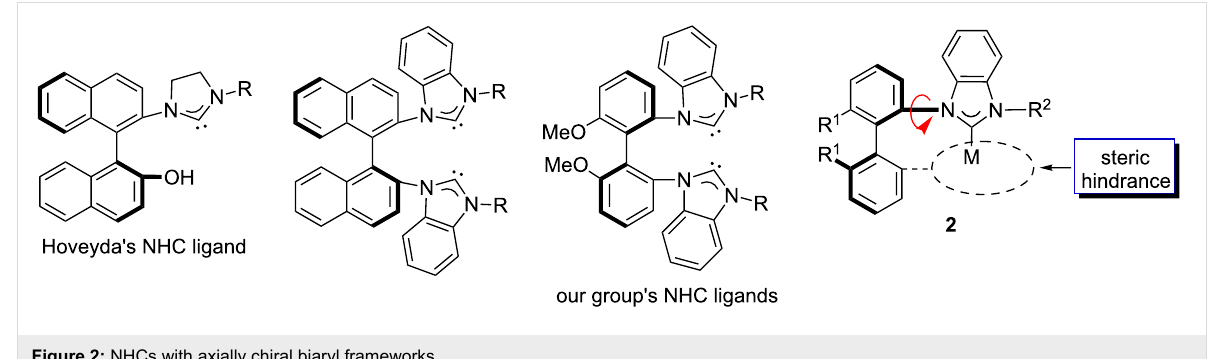
Figure 2: NHCs with axially chiral biaryl frameworks.